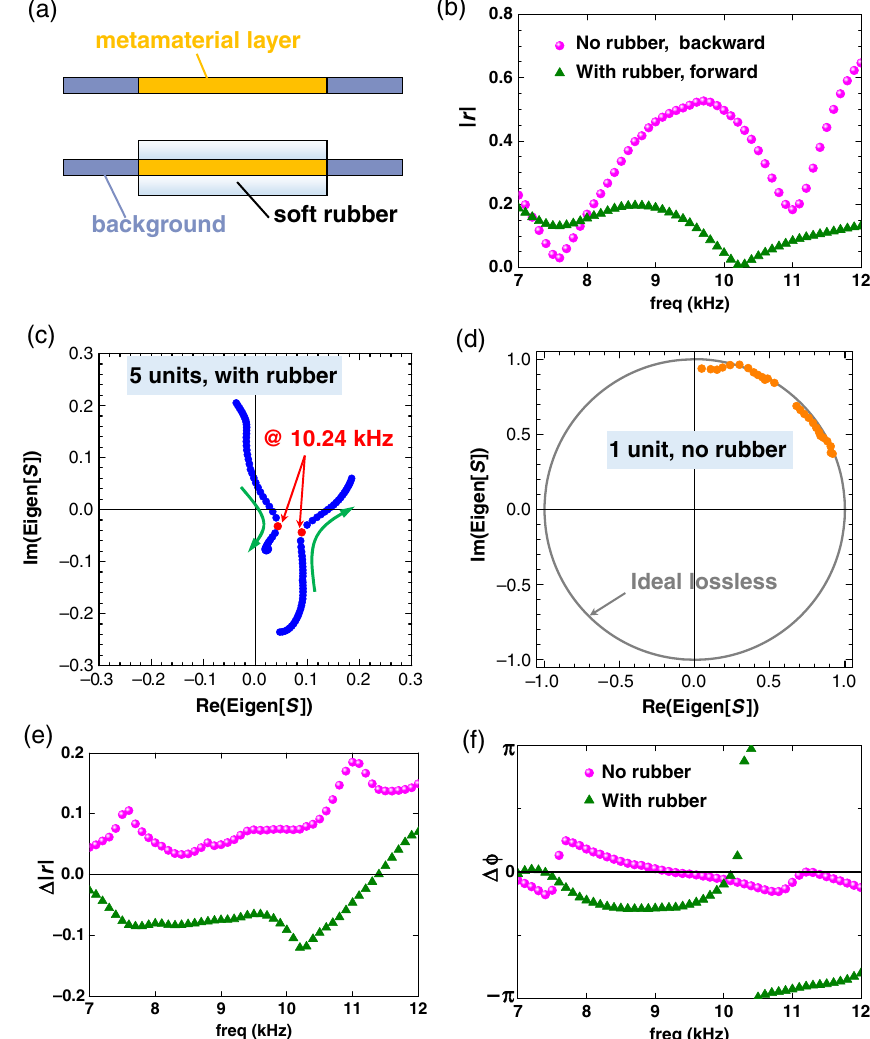
FIG. 3. Tunable asymmetry by loading lossy porous rubber. (a) Schematic of adding loss by attaching soft porous rubber patches to the metamaterial layer. (b) Measured amplitudes of the reflected waves j r j with and without porous rubber patches. (d) Eigenvalues of the S matrix at different frequencies for a 5-unit Willis metamaterial layer, with soft porous rubber patches attached on surfaces. Green arrows represent the trajectories of both eigenvalues along with the increase of the frequency. (d) Eigenvalues of the S matrix at different frequencies for a 1-unit Willis metamaterial layer, no soft porous rubber pasted. The case of ideal lossless layer is a perfect unit circle. − j r =r (e) Amplitude difference of reflected waves Δ j r j ¼ j r . (f) Phase difference of reflected waves Δ ϕ ¼ Arg ð r for both f j b j f b Þ